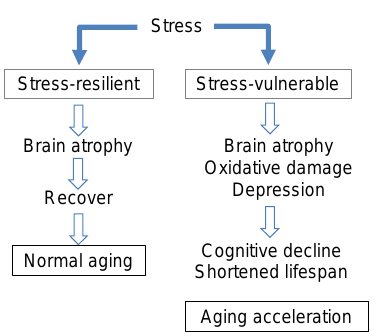
Figure 9. The relationship between stress and brain aging.